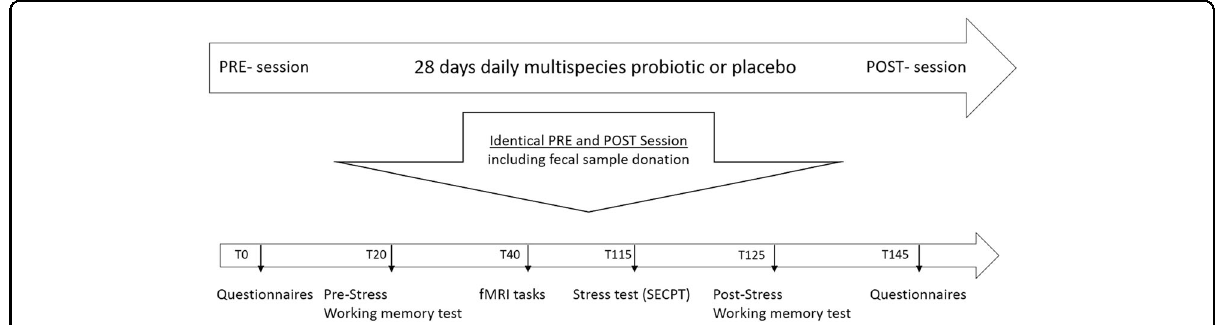
Fig. 1 Overview of the testing sessions. Each participant was tested twice, before and after 4 weeks of supplementation with probiotics/placebo. The procedure of the two sessions was the same (i.e., subjects performed the same tests in the same order). Tx: x minutes since the start of the test session. SECPT: socially evaluated cold pressor